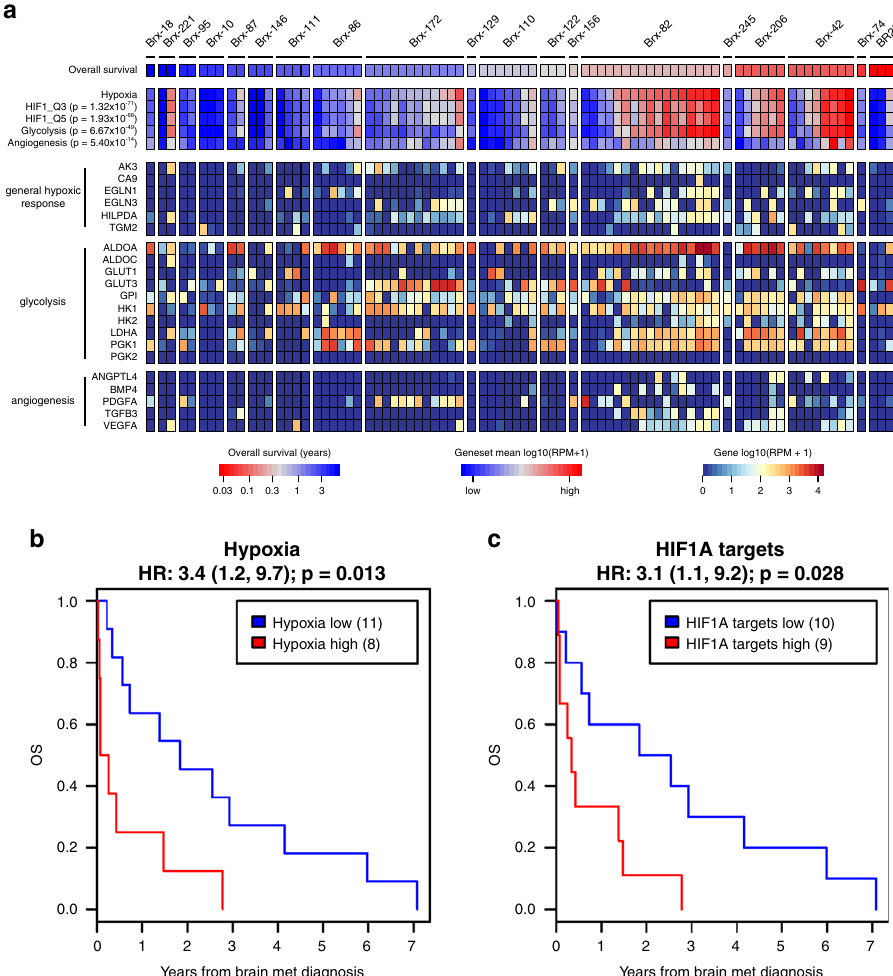
Fig. 6 Hypoxic signaling in CTCs predicts poor outcome in brain metastasis patients. a RNA-seq from CTCs enriched from whole blood of breast cancer patients with brain metastases using the iChip micro fl uidic device 24,25,32 . Heat map of the expression level of canonical HIF1A target genes. The color bars illustrate metagene analysis of hypoxia, HIF1A targets, glycolysis and angiogenesis signatures. Patients ordered by decreasing overall survival (OS) following brain metastasis diagnosis. Per-patient CTCs ordered by increasing hypoxia expression. b Kaplan – Meier analysis of the OS following brain metastasis diagnosis for patients with high average hypoxia gene expression in CTCs versus those with low average hypoxia gene expression (Hallmark Hypoxia geneset). The hypoxia-high and hypoxia-low subgroups were determined on the basis of average hypoxia gene expression across all CTCs isolated for each patient. P value calculated by log rank test. c Kaplan – Meier analysis of the OS following brain metastasis diagnosis for patients with high average HIF1A target gene expression in CTCs versus those with low average HIF1A target gene expression (Transcription Factor Targets HIF1_Q5 geneset). The HIF1A targets-high and HIF1A targets-low subgroups were determined on the basis of average HIF1A target gene expression across all CTCs isolated for each patient. P value calculated by log rank and HIF1A signaling in primary CTCs, we interrogated RNA-seq pro fi les of 83 freshly isolated single cell CTCs or CTC clusters from 19 breast cancer patients with known brain metastases 24,25,32 (Supplementary Data 6). This cohort includes patients with HR + , HER2-ampli fi ed, and TNBC breast cancer subtypes. Tran- scriptomic analysis demonstrates a range of hypoxia-related sig- naling in individual patient CTCs, with a >10-fold range in mean expression of hypoxic genes and HIF1A target genes (Fig. 6a). As in our in vitro and in vivo models, increased hypoxic signaling in CTCs signi fi cantly correlates with increased glycolytic and angio- genic signaling (glycolysis: P = 6.67 × 10 − 49 ; angiogenesis: P = 5.4 × 10 − 14 ). We collected clinical outcome data for the patients, allowing for correlation of CTC RNA-seq data with patient overall